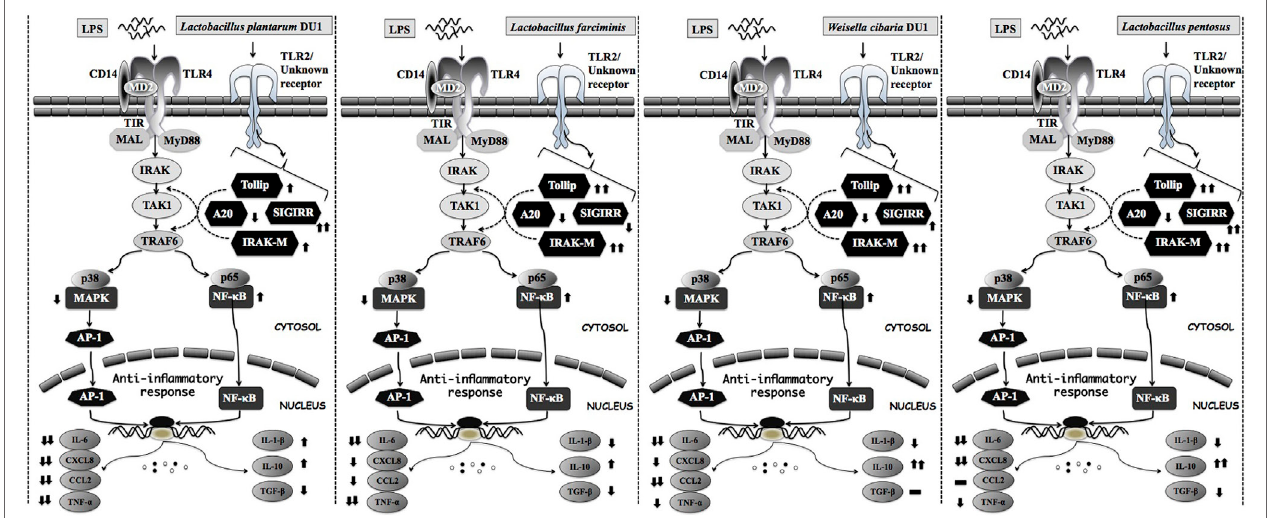
FigUre 10 | Proposed model for the mechanisms behind the immunomodulatory activity of different lactic acid bacteria strains on HepG2 and THP-1 cells under LPS induced inflammatory